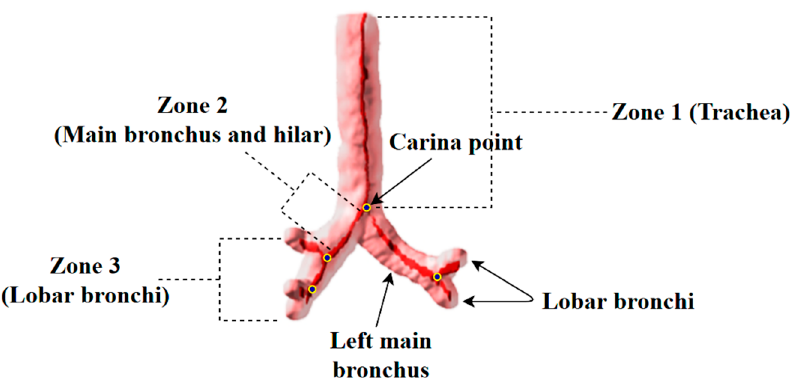
Figure 10. Different zones of the trachea and bronchial airway. Figure 10. Di ff erent zones of the trachea and bronchial